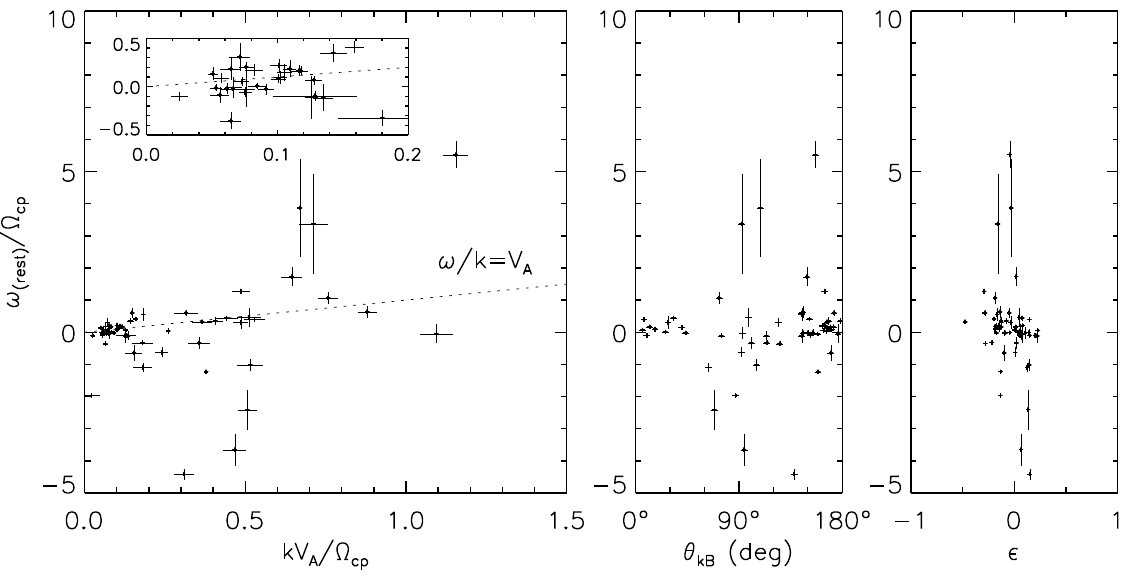
Fig. 7. Distribution of rest frame frequencies, wave numbers, propagation angles, and ellipticities in the plasma rest frame with error bar estimates. The small plot embedded in the left panel is a magnified plot of the frequencies and the wave numbers near origin. The dotted straight line in the left panel is a dispersion relation for the extended linear Alfv´en waves. See Sect. 3 for calculation of the error